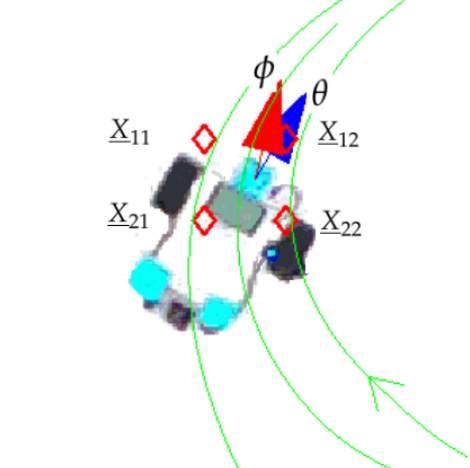
Figure 5. Coordinates of neighbour nodes in a particular mobile robot